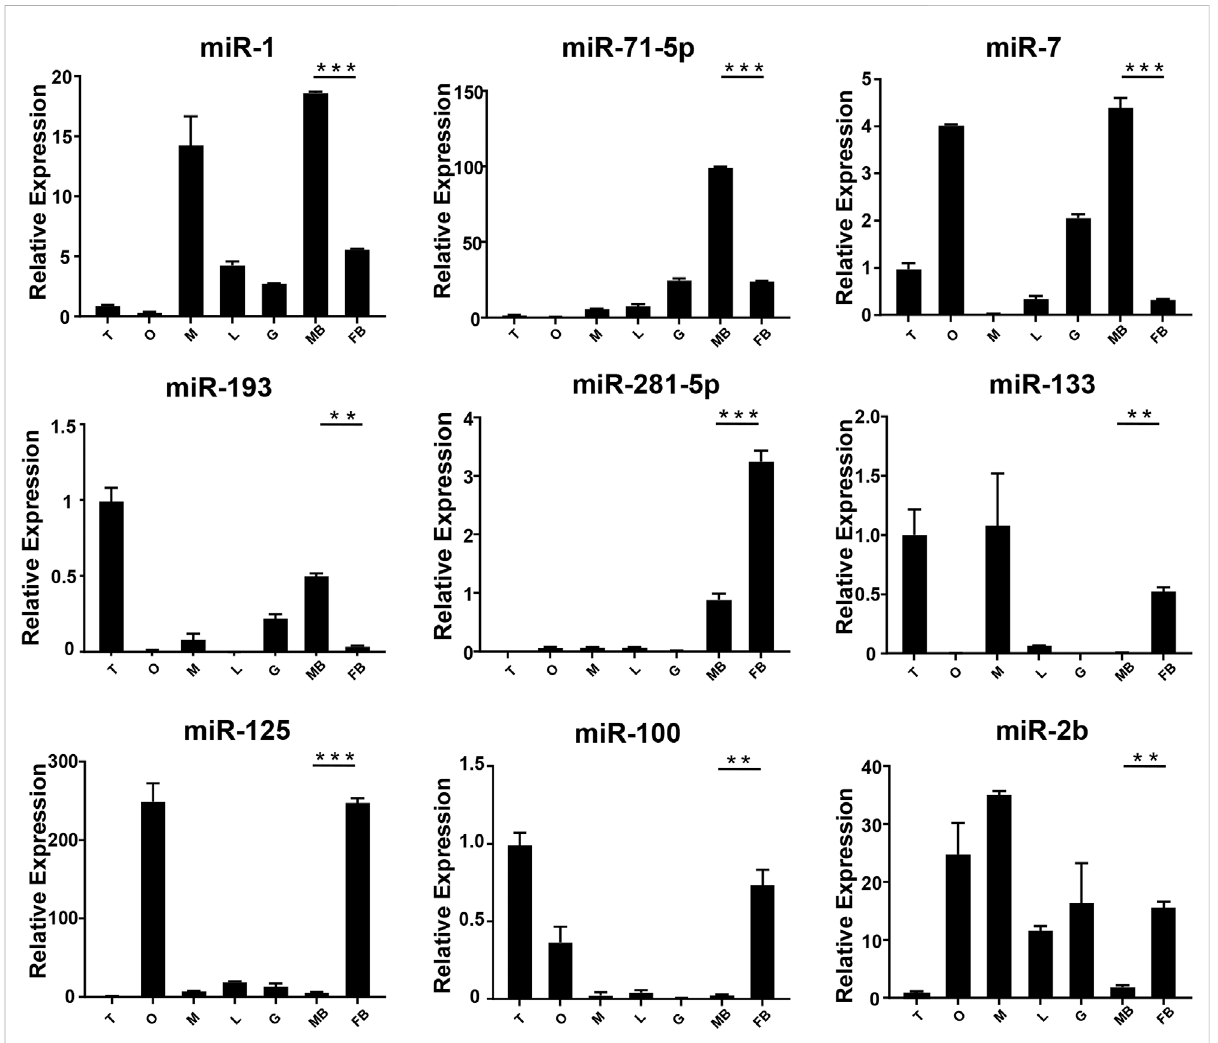
FIGURE 4 The expression of DEMs in the brain of M. rosenbergii . The endogenous reference gene was U6 , and its expression was determined by comparativeCT( ΔΔ CT )methods. T:testis;O:ovary;M: muscle;L:liver;G:gill; MB:male brain;FB: femalebrain. *:0.01 < p < 0.05;**:0.001 < p < 0.01; ***: p <